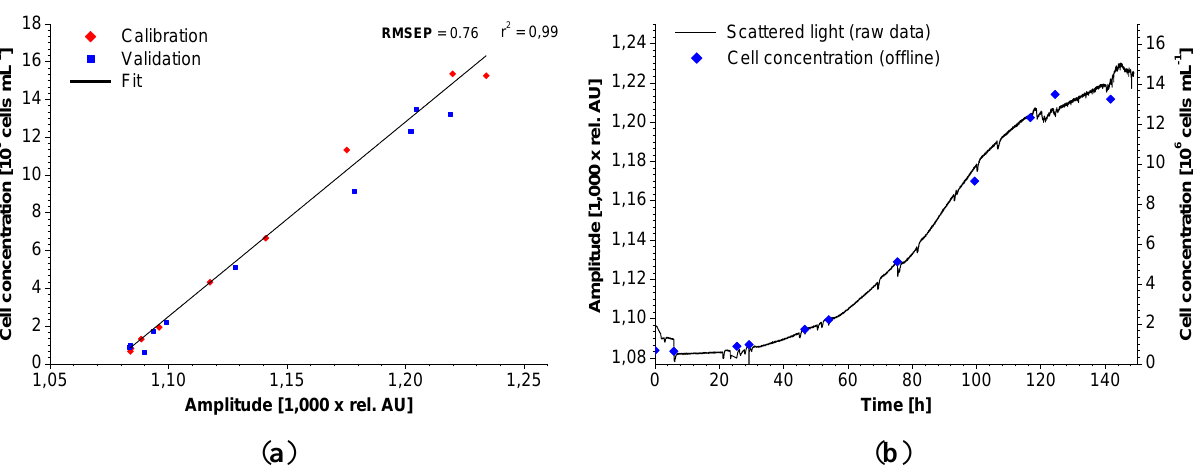
Figure 7. Calibration of the biomass sensor signal versus cell concentration using Chinese hamster ovary (CHO)-K1 and a special light shade. Red diamonds represent two experiments. Blue squares represent 1 validation experiment ( a ). Comparison between the biomass sensor signal and offline cell counting (Cedex) during the growth of CHO-K1 ( b